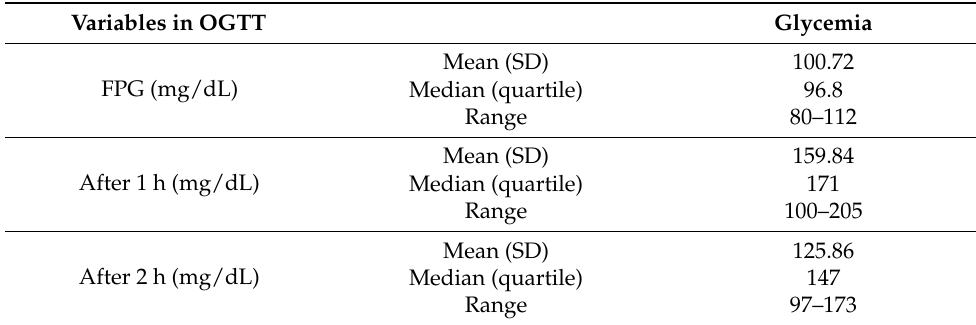
Table 1. Results of qualification of patients with GDM.